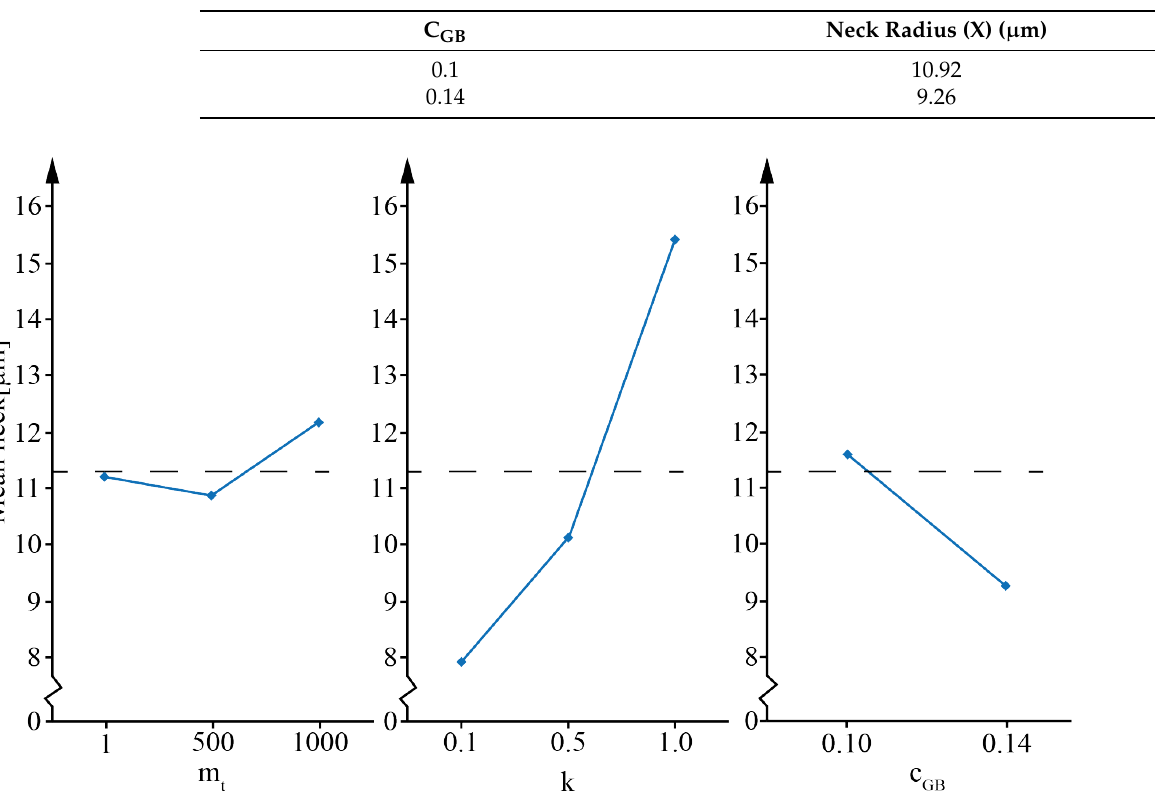
Table 9. Neck radius obtained from simulations of set 4 from Table 3.